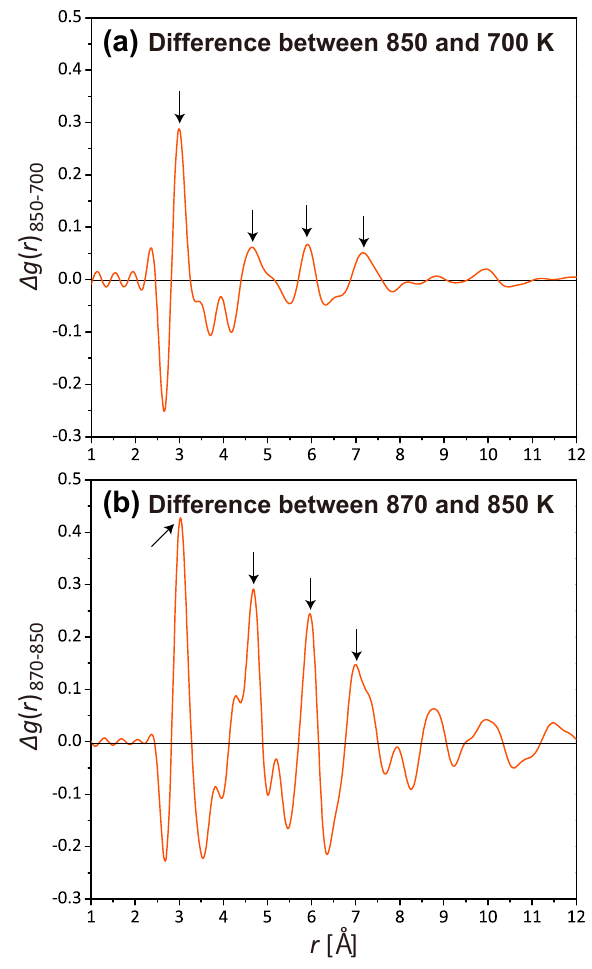
Fig. 9 Differences of experimentally obtained g ( r ) between 850 and 700 K at 5.5 GPa and between 870 and 850 K at 5.5 GPa. a Difference of g ( r ) before (700 K) and after (850 K, HPQ) the structural change at 5.5 GPa. b Difference of g ( r ) between the samples treated at 870 K (pHPQ) and 850 K (HPQ) at 5.5 GPa. Arrows indicate enhanced distances at high temperatures at 5.5